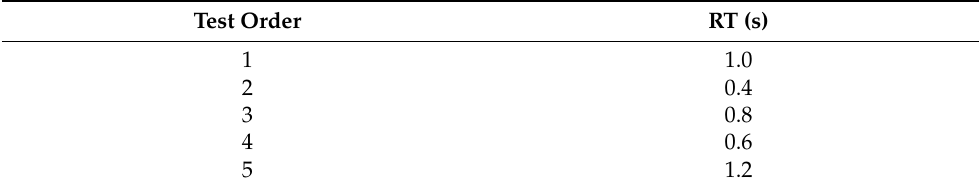
Table 10. Order of speech intelligibility test.